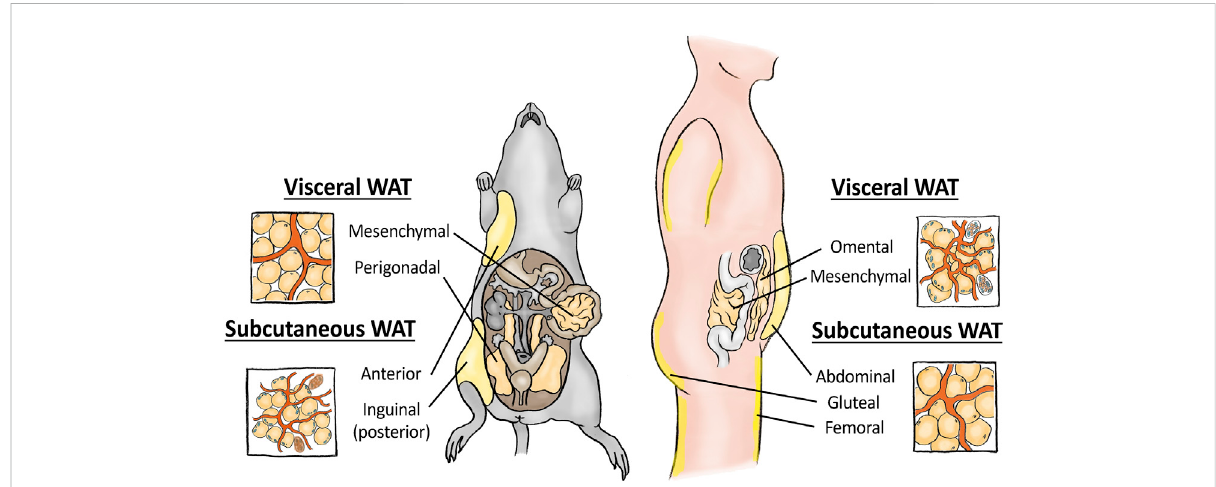
Schematic showing the most important visceral and subcutaneous white adipose tissue depots in mice (left) and humans (right), respectively. Enlarged simpli fi ed drawings of the respective tissue structures are merely indicative of the relative differences between depots, and do not include all details of the tissue